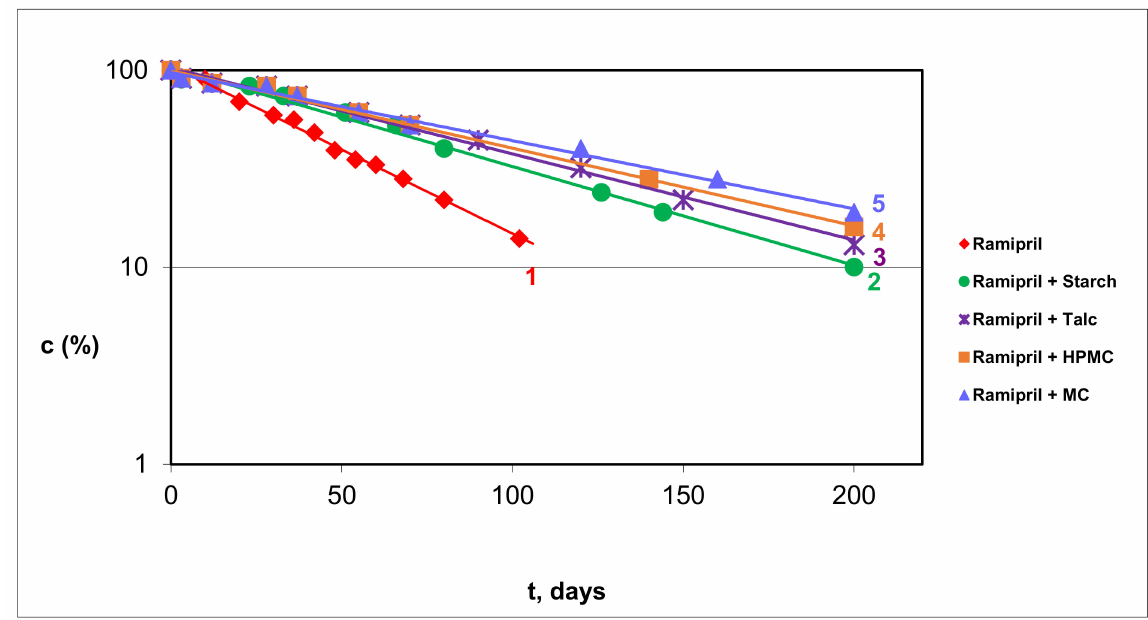
Figure 3. Kinetic curves for RAM decomposition at T = 343 K and RH = 76.0%: (1) pure RAM, (2) RAM–S, (3) RAM–T, (4) RAM–HPMC, (5) RAM–MC. Changes in RAM concentration as a function of